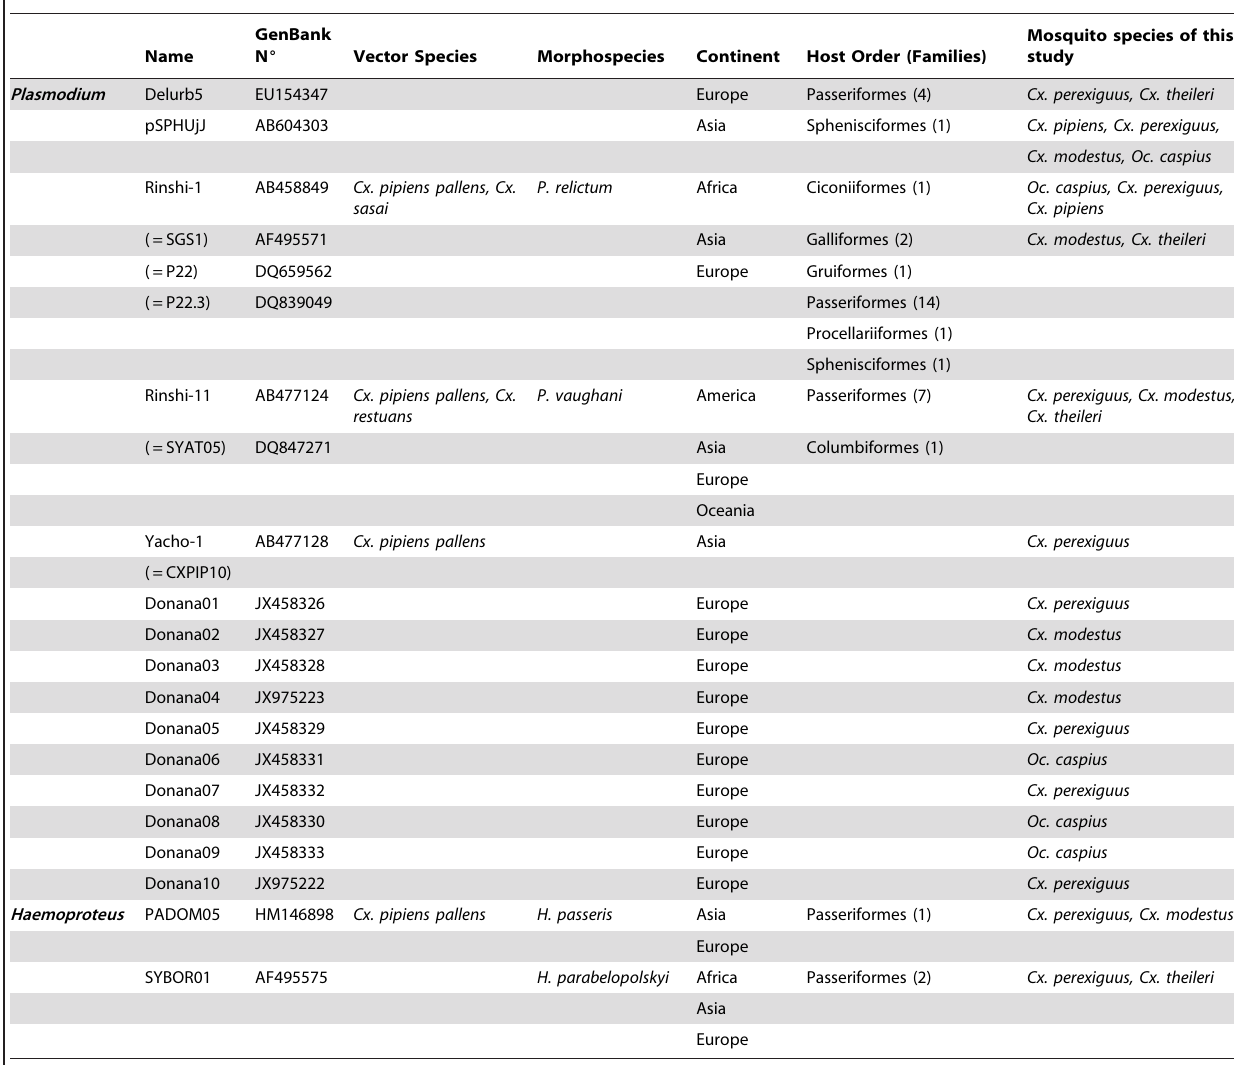
Table 2. Plasmodium and Haemoproteus lineages isolated in this